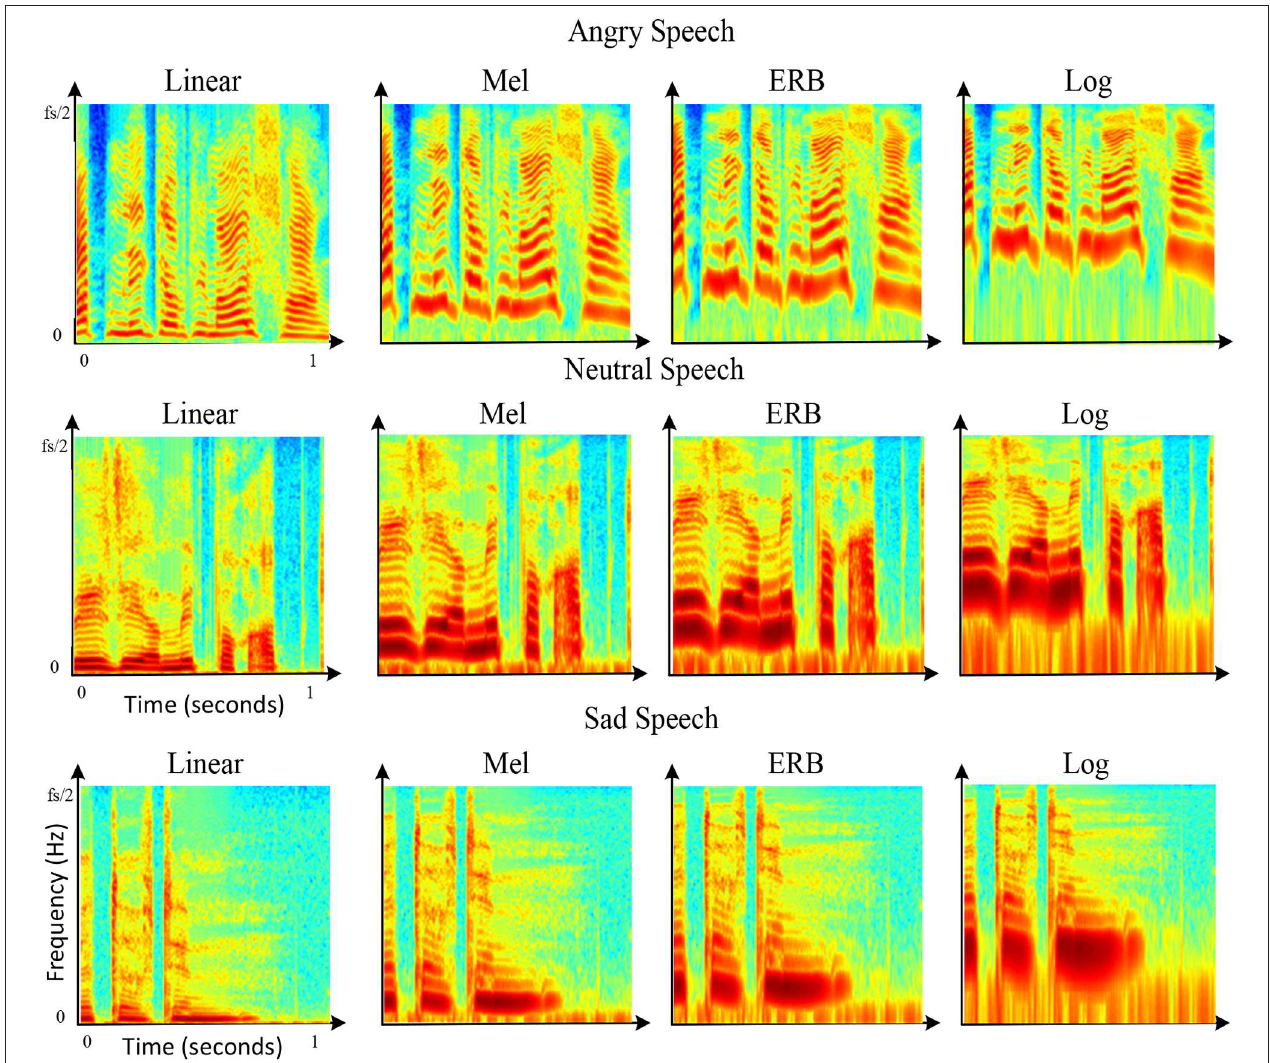
FIGURE 5 | Examples showing the effect of different frequency scales on RGB images of spectrograms. The examples show spectrograms for the same utterance pronounced by the same person with sadness, anger, and neutral speech. The time length of 1s is displayed in all examples disregarding the actual length of the sentence. The spectrograms are depicted on four different frequency scales linear, mel, ERB, and log. For all sub-pictures, the frequency range is 0 – f s /2 [Hz], and the time range is